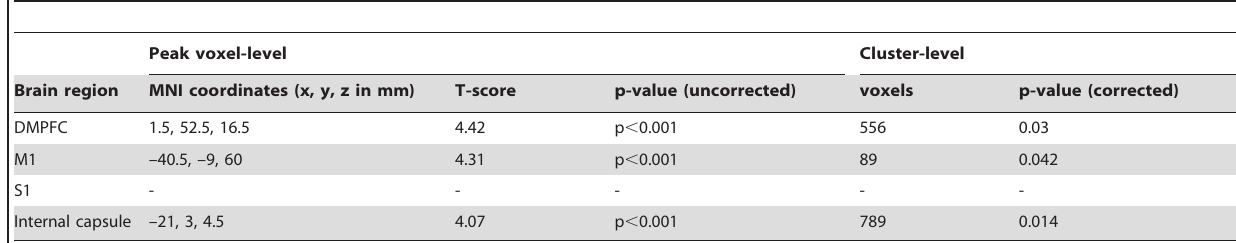
Table 2. Overview on gray and white matter findings when comparing CRPS patients to age and gender matched healthy control subjects (DMPFC: dorsomedial prefrontal cortex; M1: primary motor cortex; S1: primary somatosensory cortex).